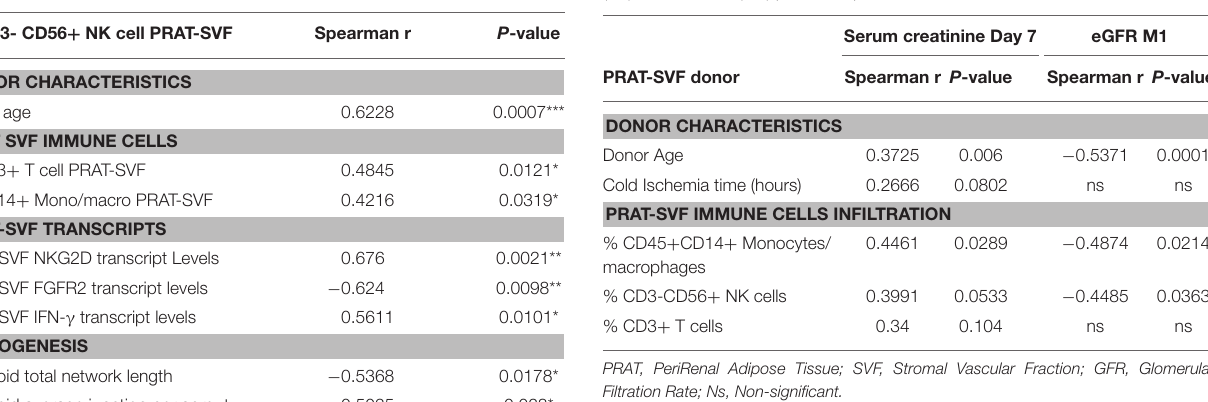
TABLE 3 | Analysis of parameters correlating with early graft function at Day 7 (D7) and 1 month (M1) post-transplant.